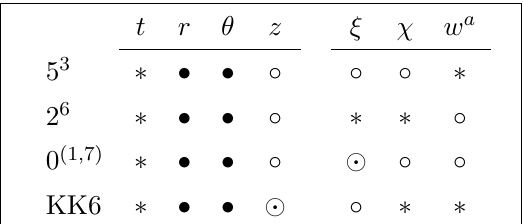
Table 1 . The con(cid:12)guration of M-theory branes that we consider. Asterisks (cid:3) denote worldvolume coordinates, empty circles (cid:14) denote smeared transverse coordinates and (cid:12)lled circles (cid:15) denote co- ordinates that the harmonic function depends on. Finally, (cid:12) denotes an otherwise distinguished direction; the Hopf (cid:12)bre for the monopole and the quadratic direction for the 0 (1 ; 7) . For this frame, we choose the EFT vectors to point out of section such that they do not contribute to the metric, but rather source the potentials of the 5